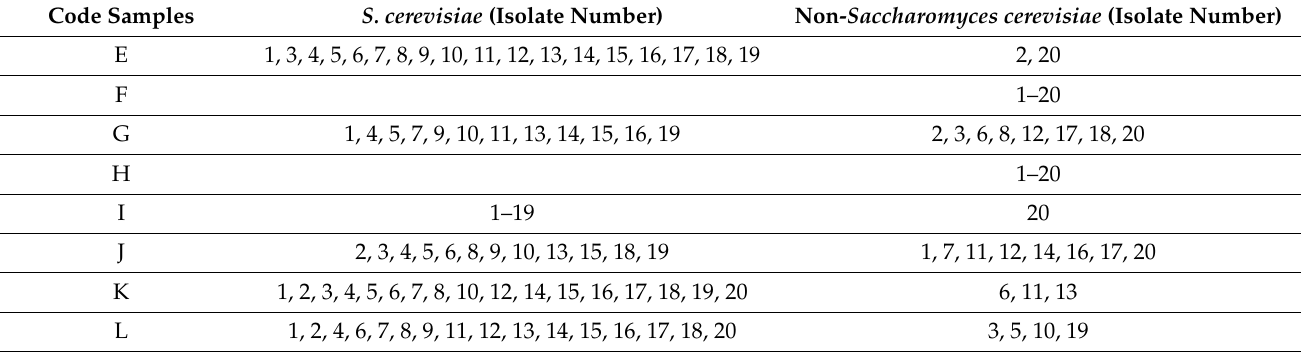
Table 6. S. cerevisiae and non- Saccharomyces isolates in each